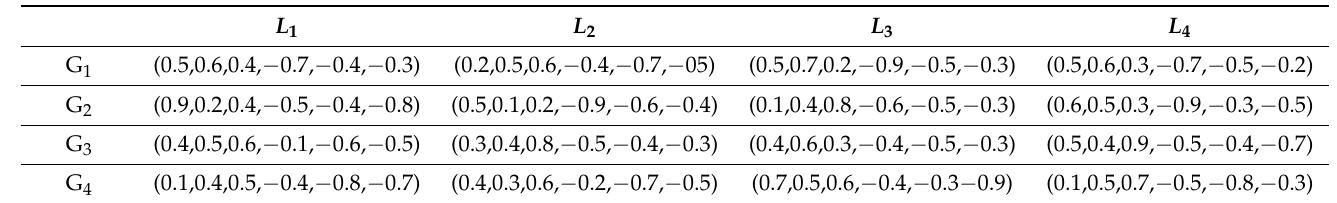
Table 3. BN decision matrix by decision-maker D 3 .